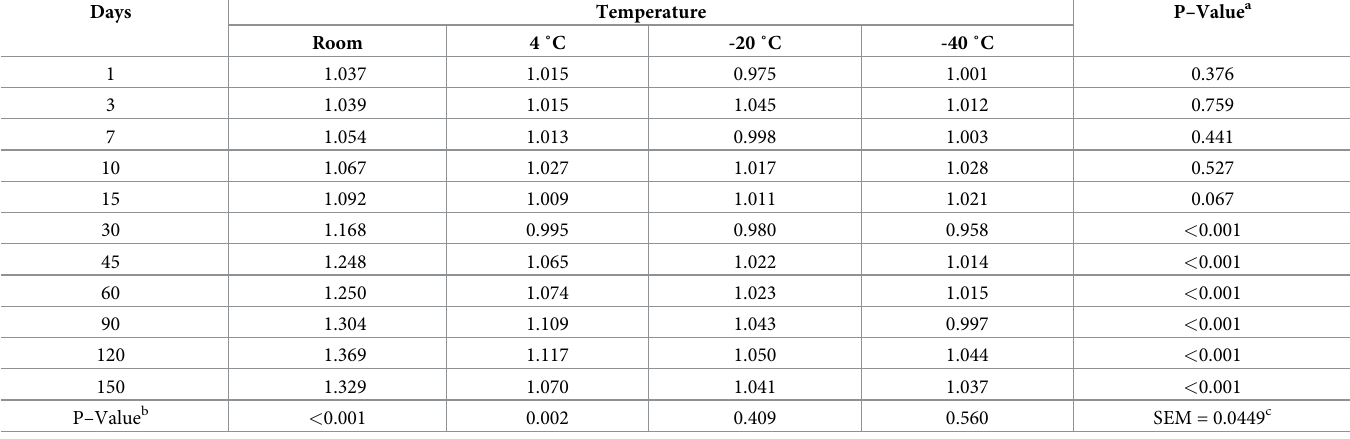
Table 1. Means, significance level (P—values) and standard error of the mean (SEM) obtained for relative creatinine as a function of time (days) and storage tem- perature in urine samples from cattle.